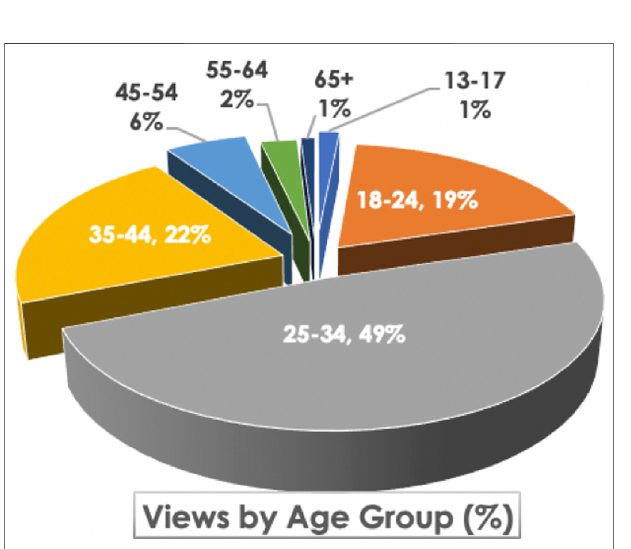
Figure 9 . The average view duration in these platforms was 1 min and 29 s for mobile devices and 2 min and 3 s through the computer.